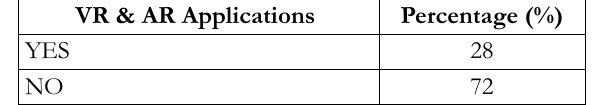
Table 10. Percentage of teachers using AR or VR applications (Questionnaire)